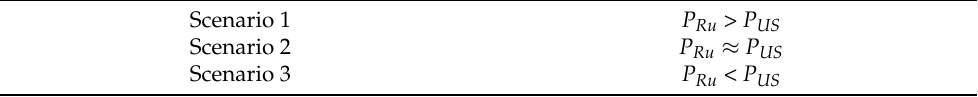
Table 3. Price scenarios arising from the Russia-United States subgame.